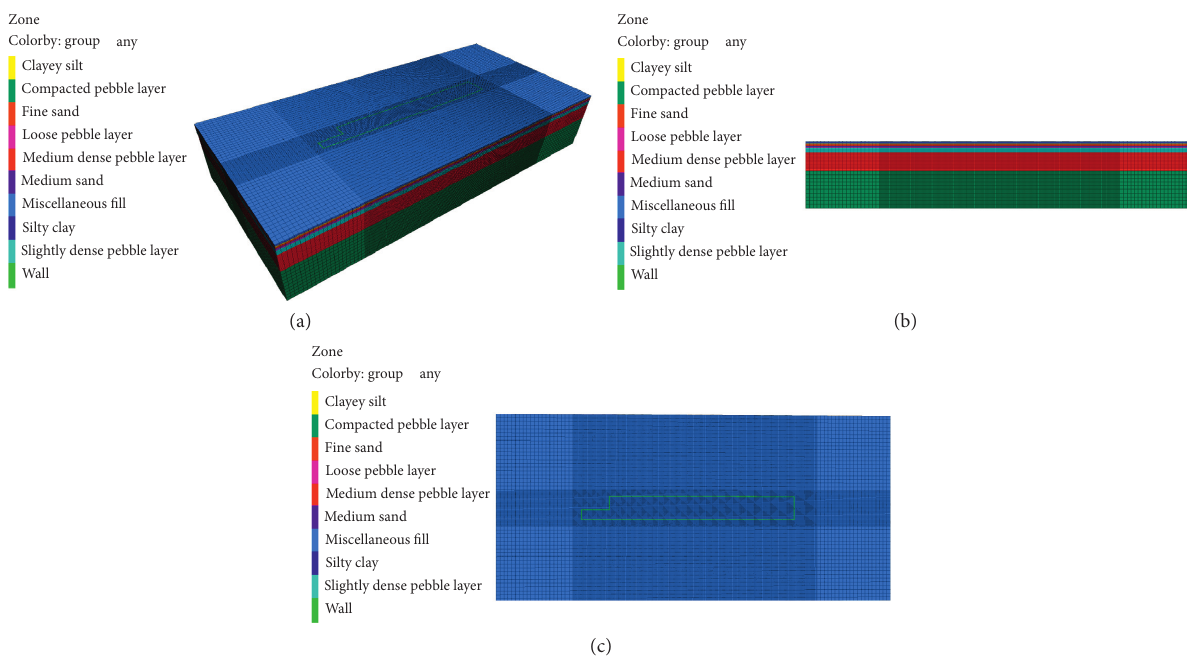
Figure 13: 3D model of the foundation pit and soil strata. (a) Model mesh diagram. (b) Model cross section. (c) Model top